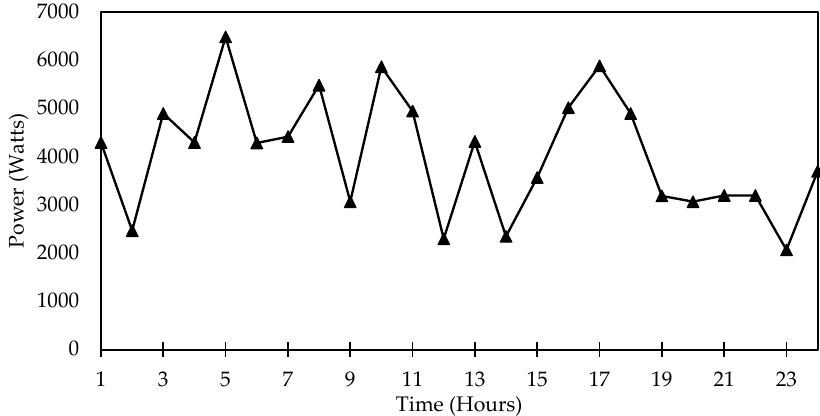
Figure 18. Demand curve of commercial load.